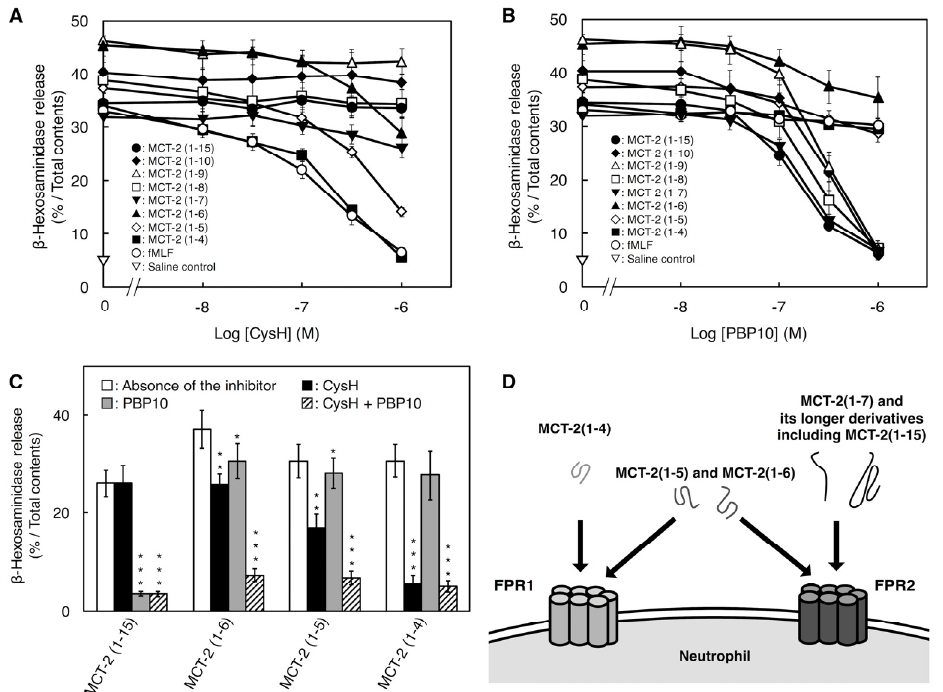
Figure 3. Involvement of FPR1 and FPR2 in β -hexosaminidase release by differentiated HL-60 cells stimulated with MCT-2(1–15) and its derivatives. ( A , B ) Concentration-dependent inhibitory effects of inhibitors against FPR1 (CysH) ( A ) or FPR2 (PBP10) ( B ) on β -hexosaminidase release induced by MCT-2(1–15) and its derivatives. ( C ) Inhibitory effects of CysH (1 µ M; black), PBP10 (1 µ M; gray), or a combination of both inhibitors (1 µ M PBP10 and 1 µ M CysH; slash lines) on the stimulation of β -hexosaminidase release by MCT-2(1–15) and its derivatives. White bars indicate the stimulation of MCT-2(1–15) and its derivatives in the absence of the inhibitor. The stimulatory concentrations of MCT-2(1–15) and its derivatives were the concentrations that caused a 60% response of the maximum effect. The ability of each peptide in the absence or the presence of the inhibitors was expressed as a percentage of the total enzyme activity, which was the enzyme activity leaked after disruption of the cells with 0.05% Triton X-100 (%/Total). Data are expressed as the mean ± SE of four to six independent experiments. * p < 0.05; ** p < 0.01; *** p < 0.001, values significantly different from each peptide in the absence of the inhibitors. ( D ) Receptor preference of MCT-2(1–15) and its derivatives. N-terminal derivatives of MCT-2 with seven amino acid residues [MCT-2(1–7)] or longer than it specifically activate FPR2, whereas MCT-2(1–4) induces the specific activation of FPR1, as well as MCT-2(1–6) and MCT-2(1–5), which activate both FPR1 and FPR2.